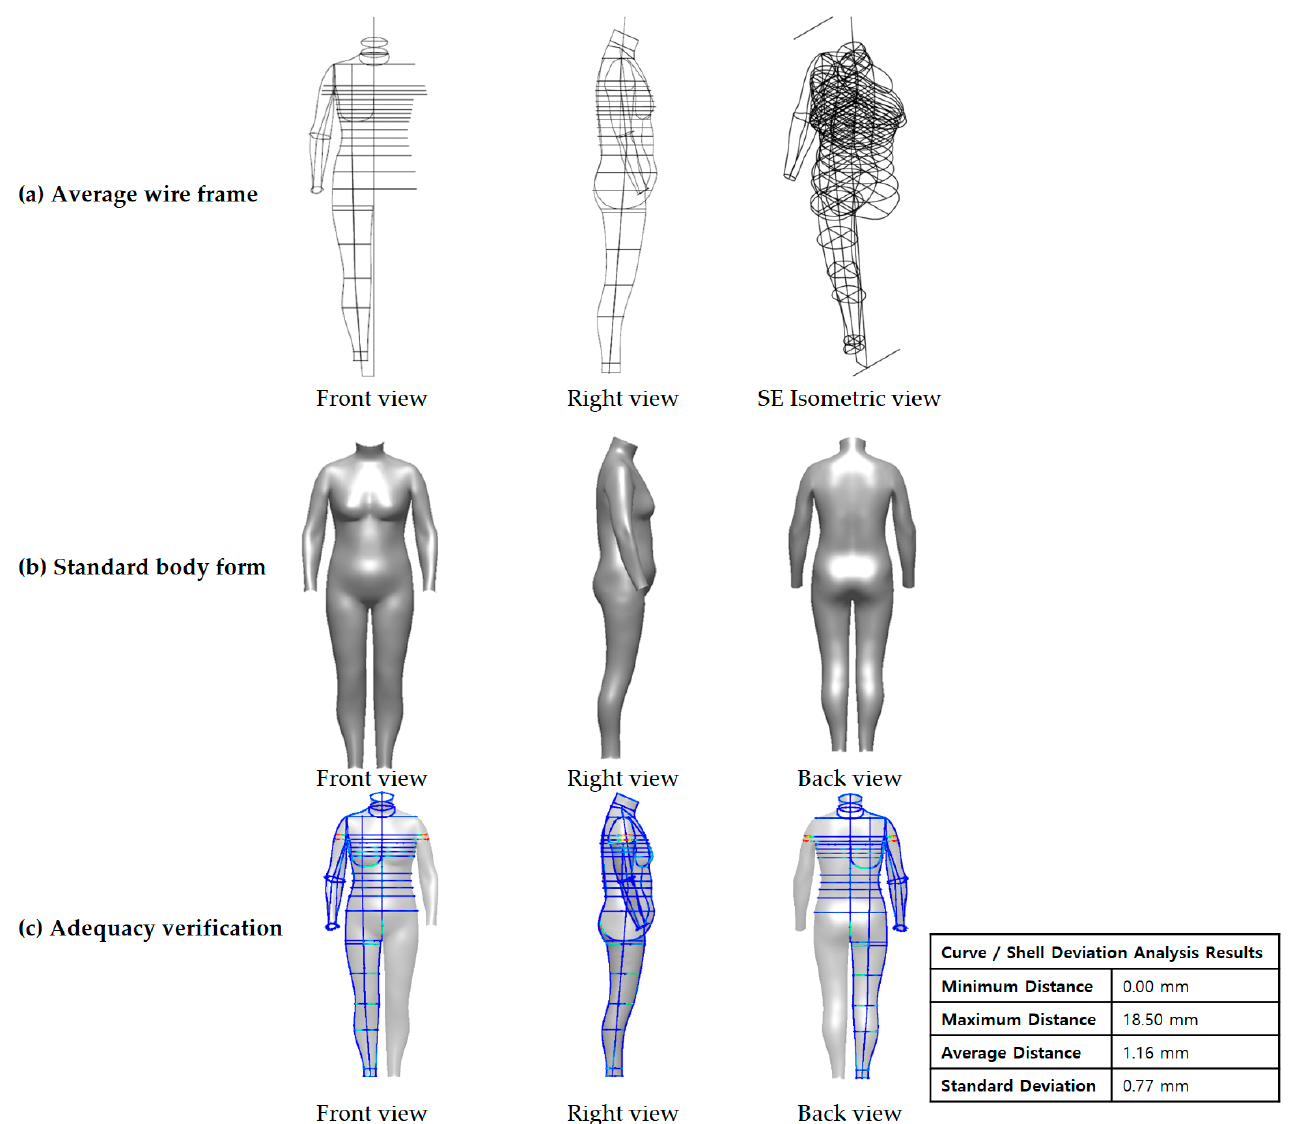
Figure 4. Results of development of standard body form for new senior women.